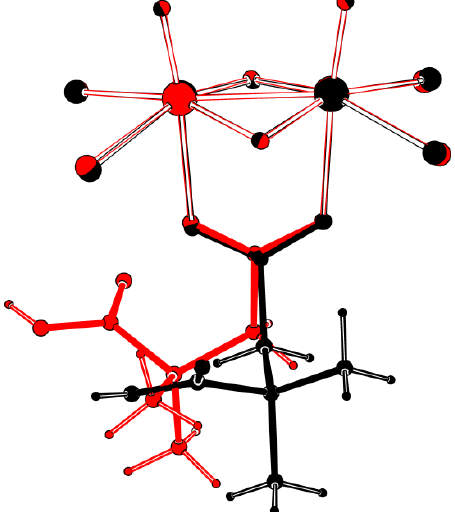
Figure 4. An overlay of the crystallographically independent complex anions in 1